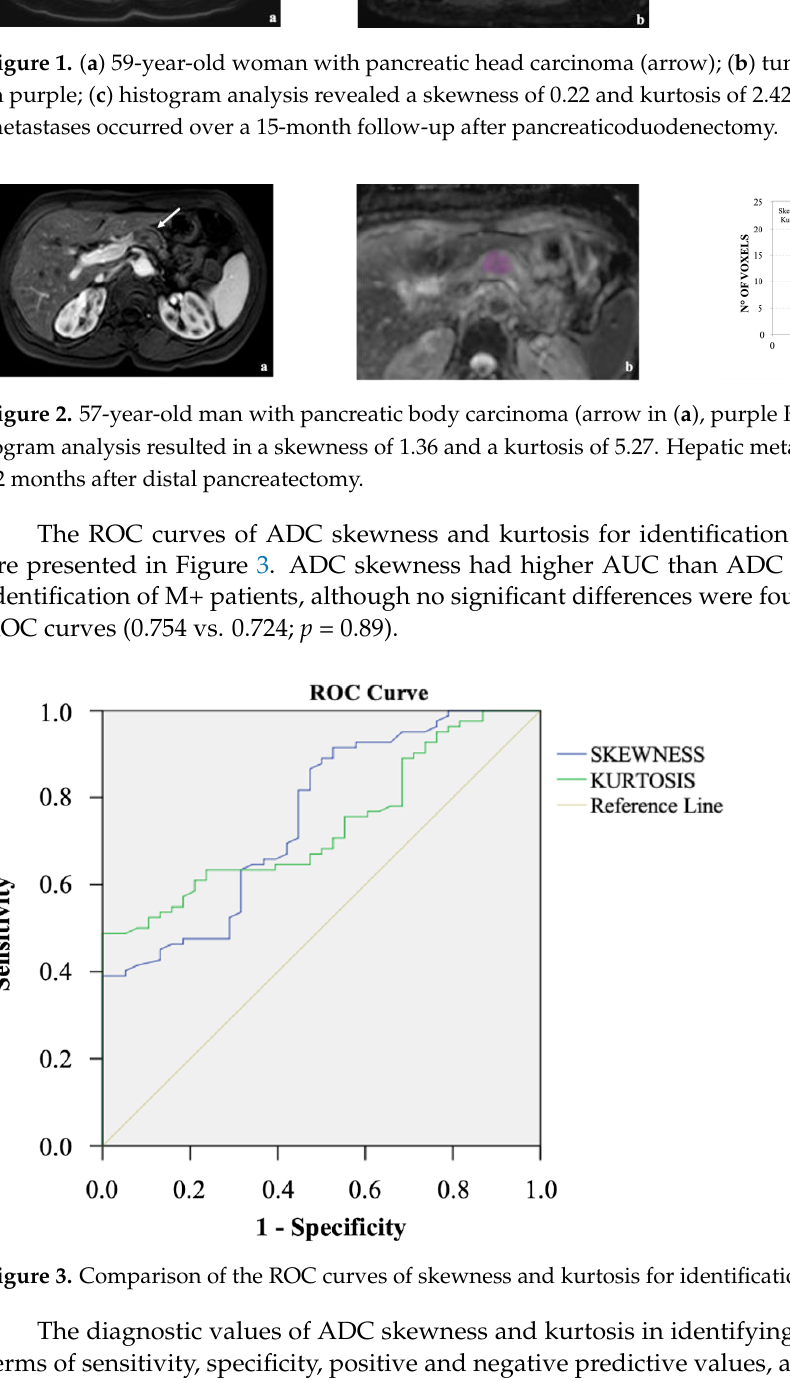
Figure 3. Comparison of the ROC curves of skewness and kurtosis for identification of M+ patients. The diagnostic values of ADC skewness and kurtosis in identifying M+ patients in terms of sensitivity, specificity, positive and negative predictive values, and accuracy are presented in Table 4. Table 4. Diagnostic values of skewness and kurtosis in identifying M+ patients.